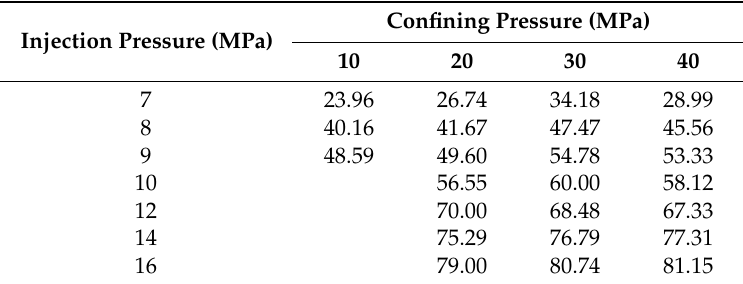
Table 2 . Proportion of liquid CO 2 length in sample calculated using Equation (5) (%). Table 2. Proportion of liquid CO 2 length in sample calculated using Equation (5)